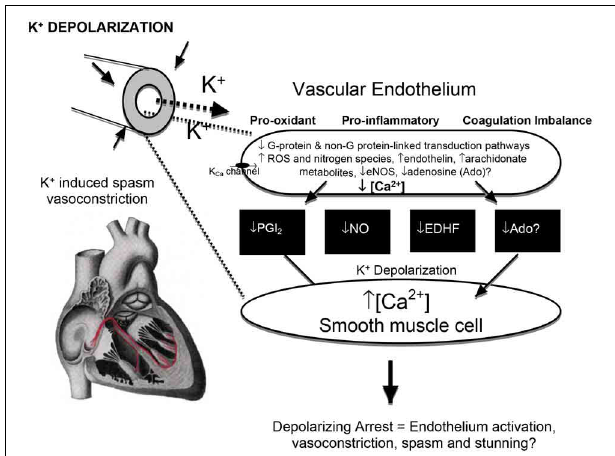
FIGURE 6 | The effect of high potassium on the endothelium and smooth muscle interactions, vasoconstriction, and possible injury. Membrane K + depolarization decreases the driving force for Ca 2 + entry into endothelial cells through Ca 2 + -activated K + channels (Coleman et al., 2004), increases voltage sensitive endothelial NADPH oxidases (and other oxidants) (Sellke et al., 1993; Li and Shah, 2004) which can lead to vascular smooth muscle contraction and vasoconstriction (van Breemen et al., 1997) from a reduced availability of endothelial-derived vasodilators [prostacyclin (PGI 2 ), nitric oxide (NO), non-NO/PGI 2 relaxation factors (EDHF’s) and adenosine] (He, 2005; Wu et al., 2005; Yang and He, 2005). Hyperkalemia in cardioplegia has been linked to loss of ACh-dependent relaxation, which may be exacerbated by ischemia and hypothermia (Tyers, 1997; Parolari et al., 2002; Yang and He,